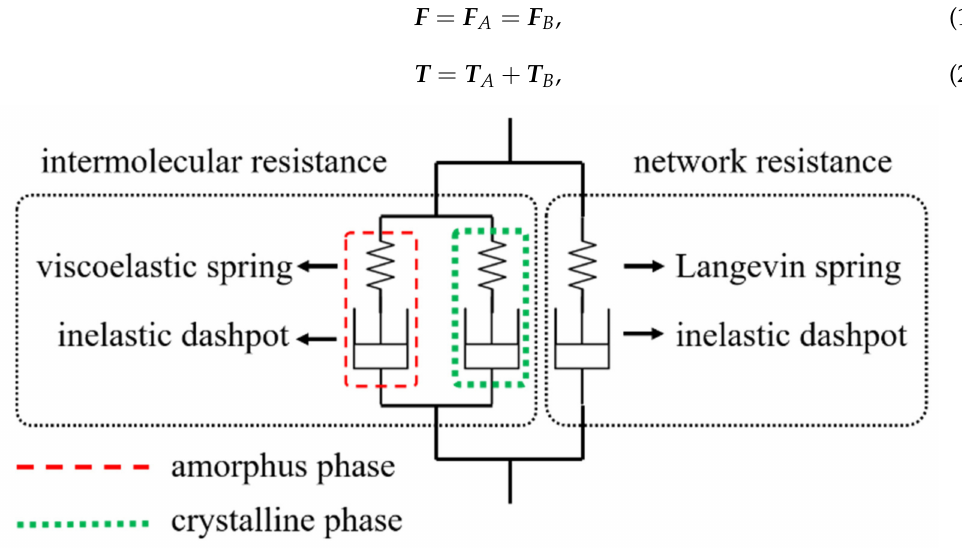
Figure 6. Schematic representation of the modified VBO